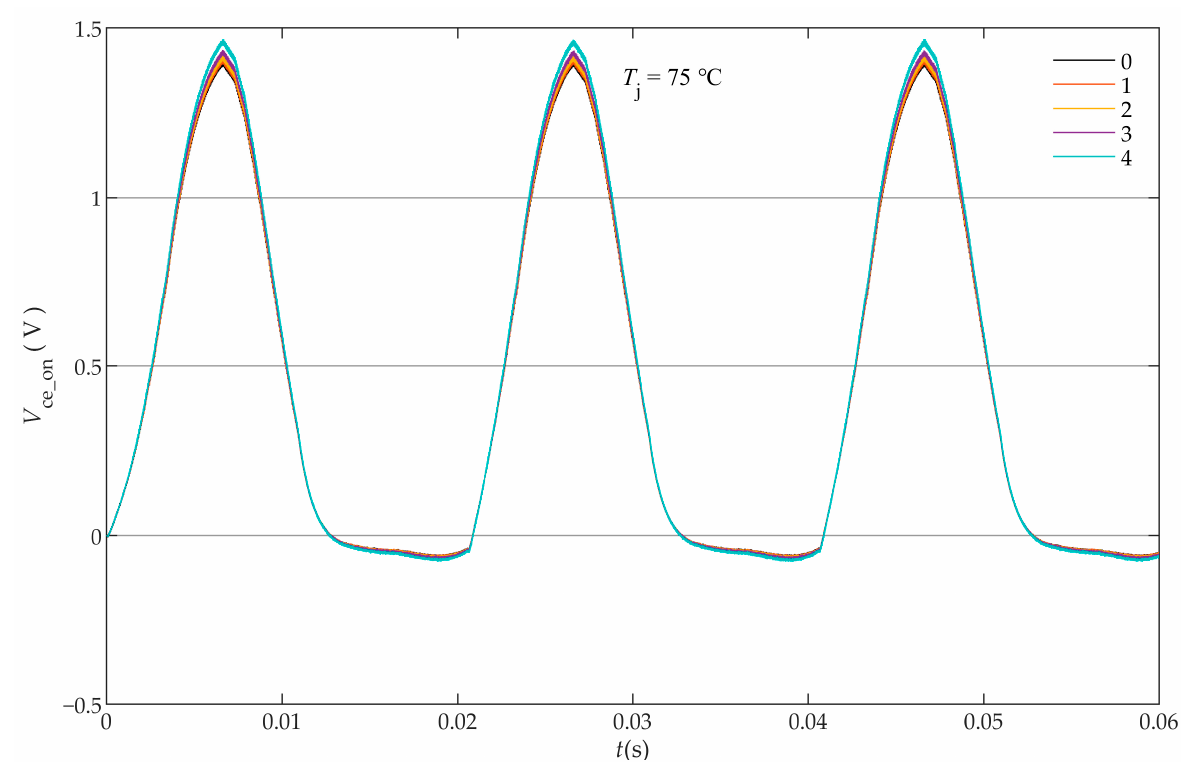
Figure 9. Online monitoring results with different broken bond wires in the case of T j = 75 °C.